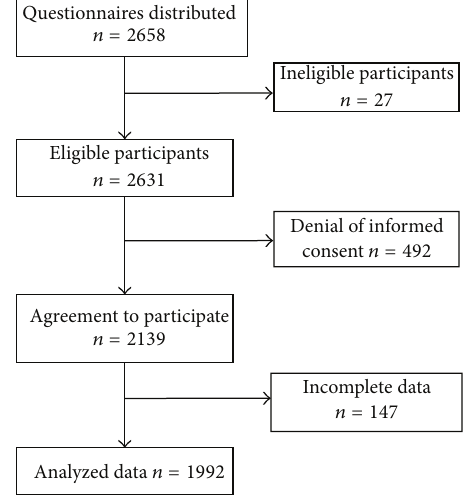
Figure 1: Flow chart of recruitment